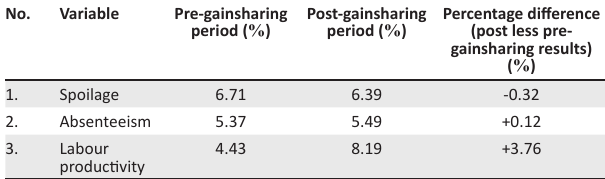
TABLE 4: Pre- and post-gainsharing comparison.